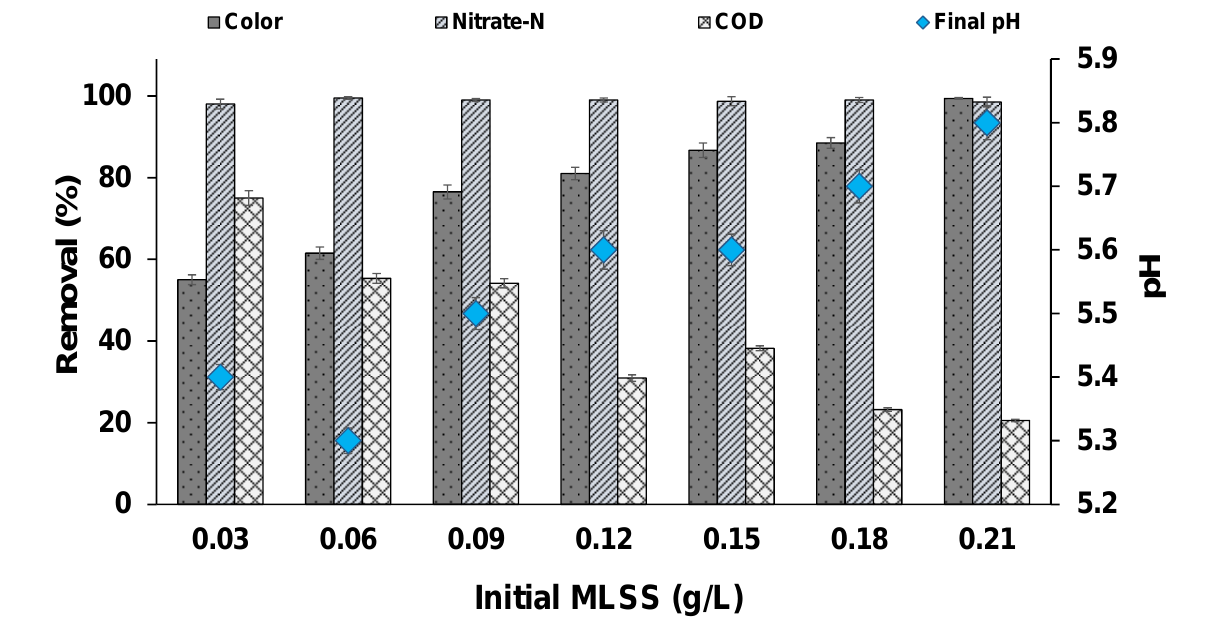
Figure 3. Effect of biomass concentration on MO decolourization (temperature: 30 ± 2 °C; volume: 150 mL; MLSS: 0.03 to 0.21 g/L; RPM: 110 ± 2; time: 96 h).